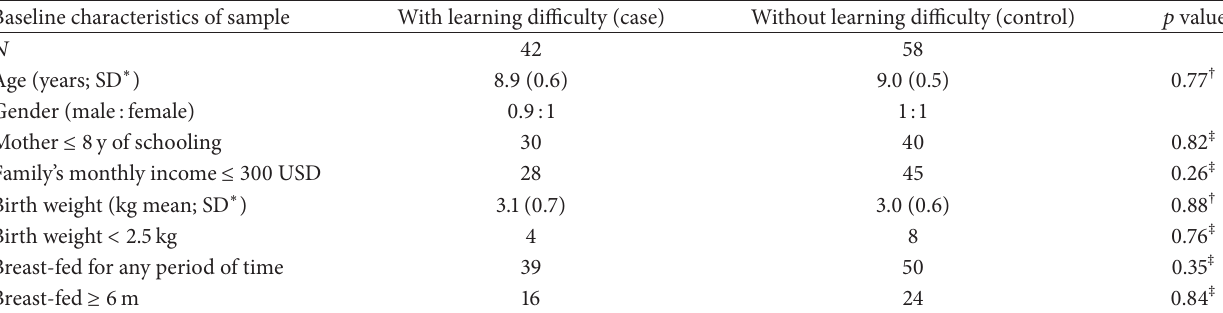
Table 1: Baseline characteristics of sample, by group.